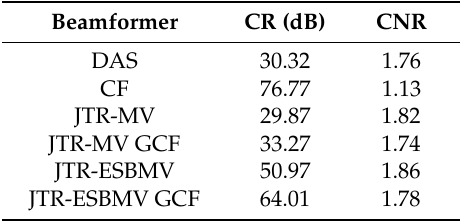
Table 5. CR and CNR for experimental anechoic